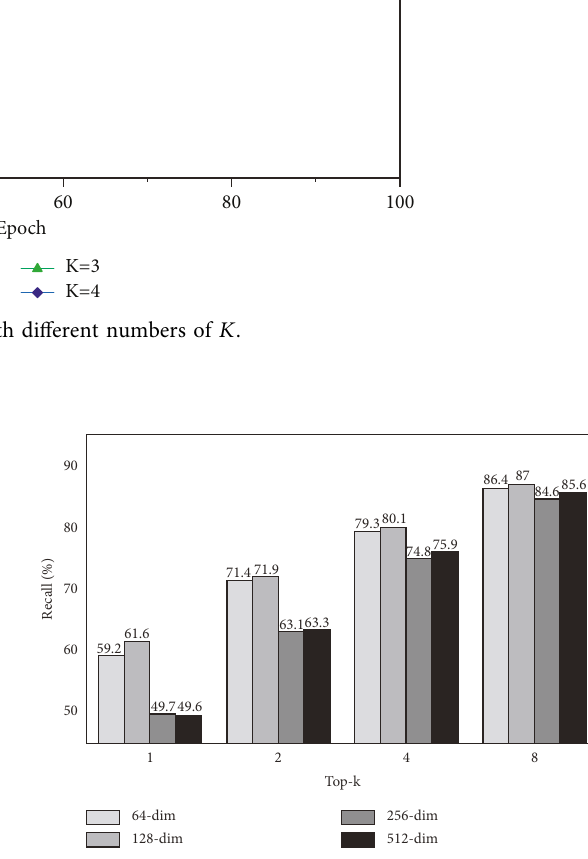
Figure 8: Experimental results on different dimensions of metric embedding.